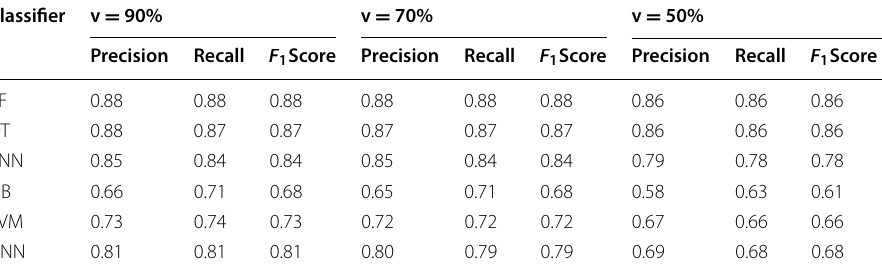
Table 3 Prediction results considering different variance utilizing the dataset of user U2 Classifier v =